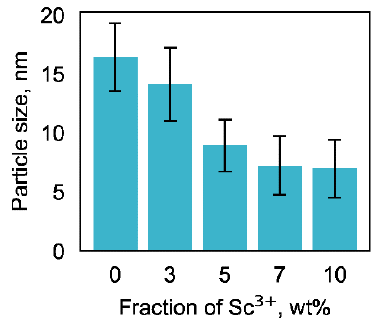
Figure 1. Particle size in obtained colloids of Sc-doped titania. Table 1. Calculated and EDX amounts of Sc ions in synthesized Sc-doped titanium dioxide. Sc Calculated, Sc calculated, wt.%